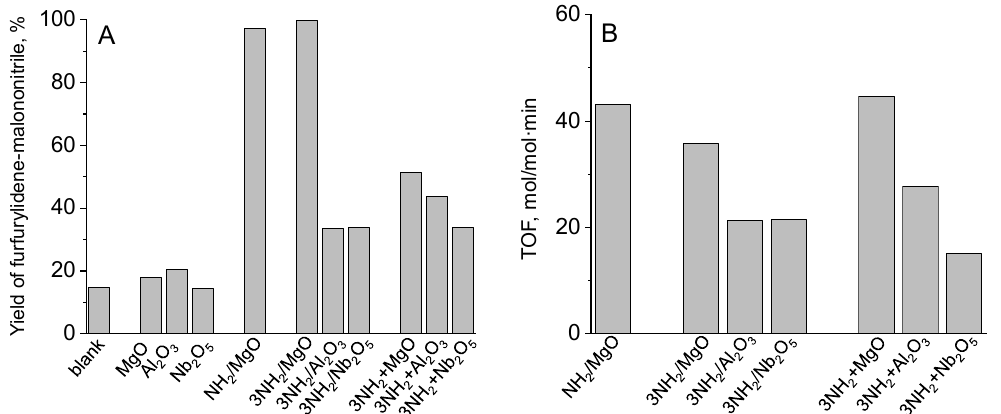
Figure 9. ( A ) the results of the Knoevenagel condensation between furfural and malononitrile performed for 30 min at 60 °C in the presence of synthesized samples. ( B ) activity of catalysts in the condensation between furfural and malononitrile, expressed as turnover frequency (TOF) calculated as moles of furfural converted on one mole of TAEA or APTMS for one minute.